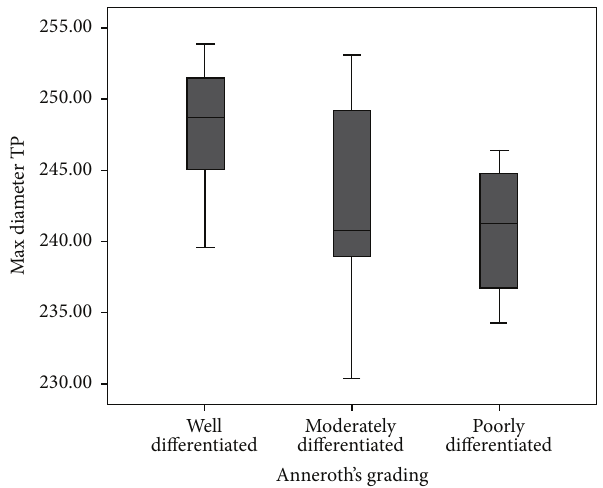
Figure 3: This graph depicts the relation of maximum diameter at tumor proper with Anneroth et al. grading in oral squamous cell carcinoma patients (graph depicted “maximum diameter tumor proper as Max diameter TP”) ( 𝑛 = 32 ). The statistical significance was calculated using Chi-square test (value = 7.351) and statistical significance shown as ∗ 𝑃 = 0.025